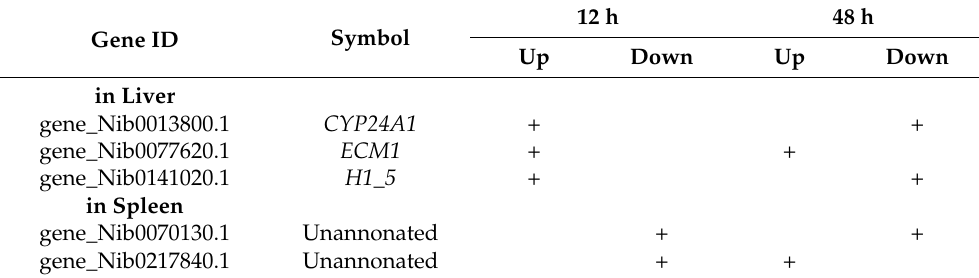
Figure 1. Numbers of Differentially Expressed Genes in Each Comparison, Followed by the Interac- tion Venn-diagram Analyses of these Comparisons. Table 2. The Shared Differentially Expressed Gene Information of Tissues at Different Times.